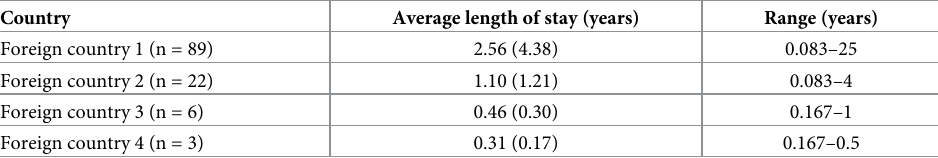
Table 3. Mean (and standard deviations) length of stay and range of length of stay in non-English-speaking countries.